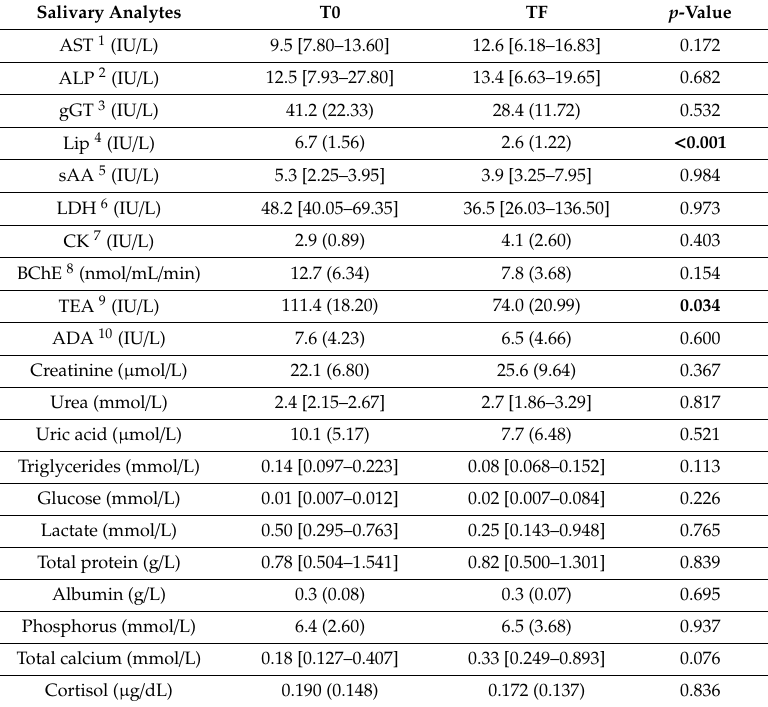
Table 2. Means (standard deviation) or medians [interquartile ranges, 25–75%] of a biochemical analysis performed in saliva from six dairy cows randomly selected from a larger population, the day of lameness diagnosis (T0), and after treatment when no sign of lameness was observed (TF). p -values in bold identify statistically significant di ff erences between